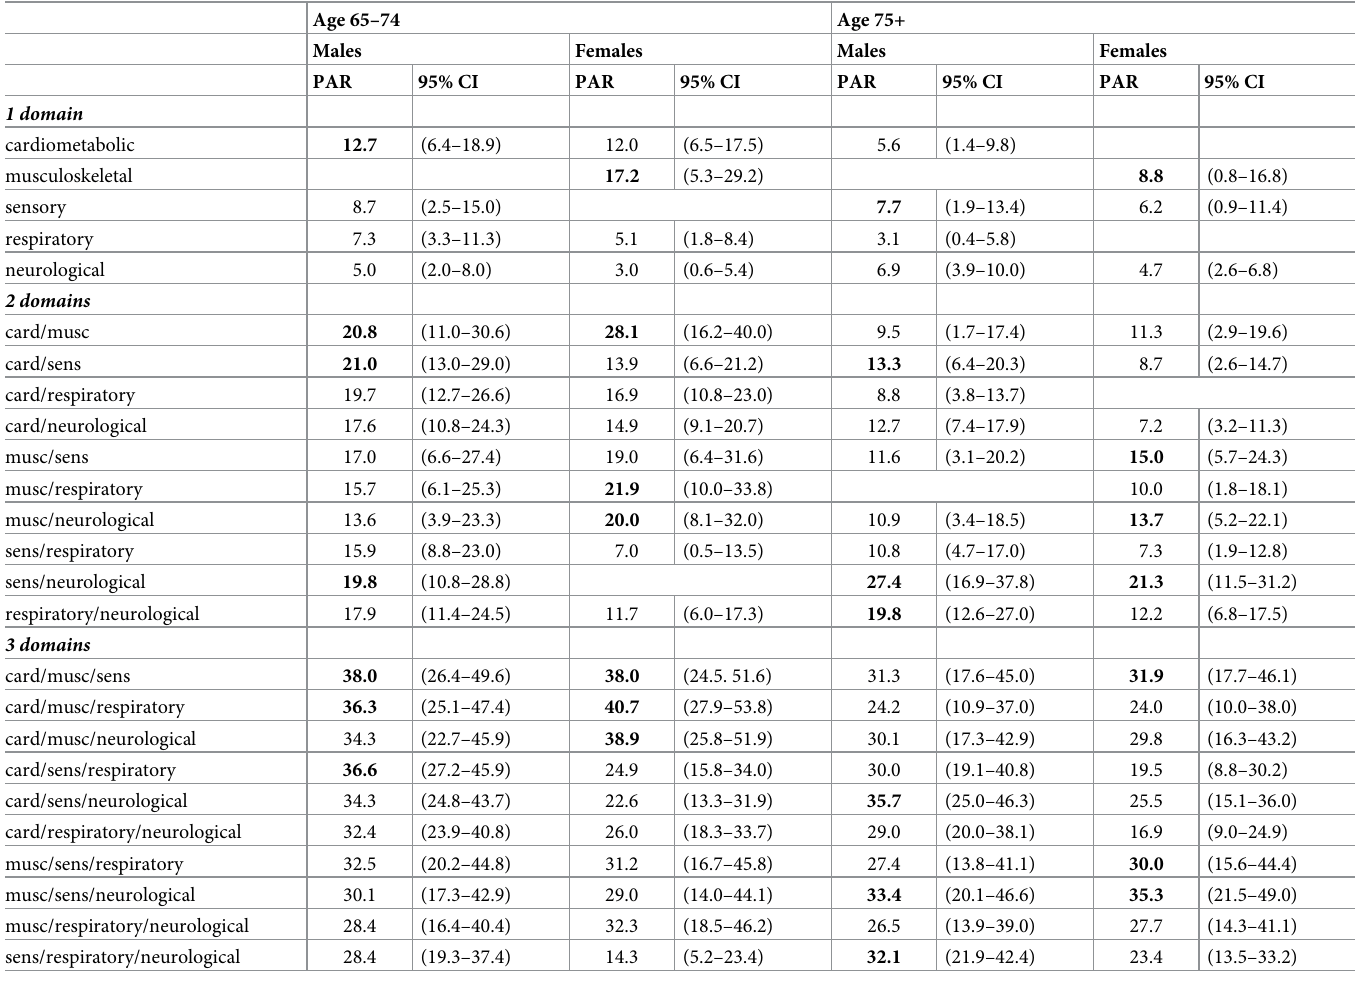
Table 5. Population attributable risk for instrumental activities of daily living disability by disease cluster after five years of follow up, stratified by age and sex ab